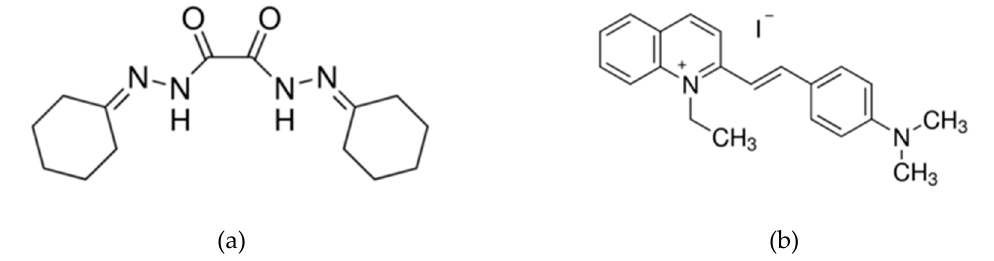
Figure 2. ( a ) chemical structure of Bis(cyclohexanone)oxaldihydrazone, the Cr(III) specific ionophore; ( b ) Cr(VI) selective compound quinaldine red.